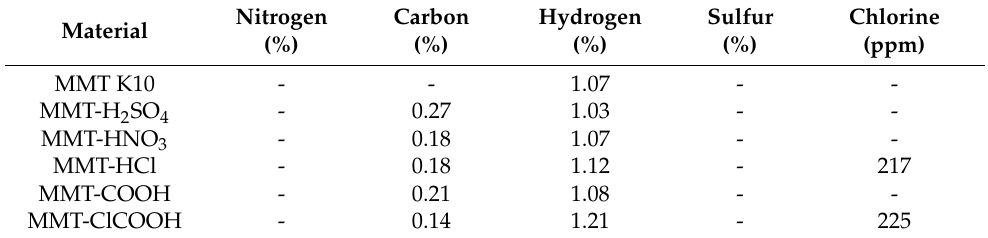
Table 2. Results from elemental analysis of raw and acid treated montmorillonite.